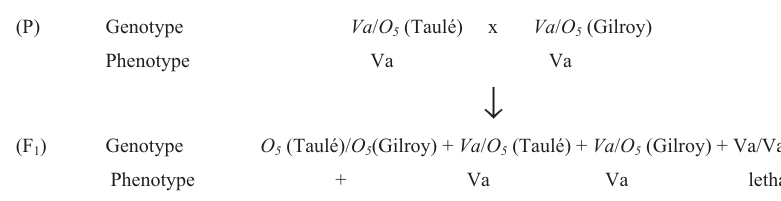
Figure 1 - Crosses performed in order to obtain the homokaryotypes O 5 /O 5 .